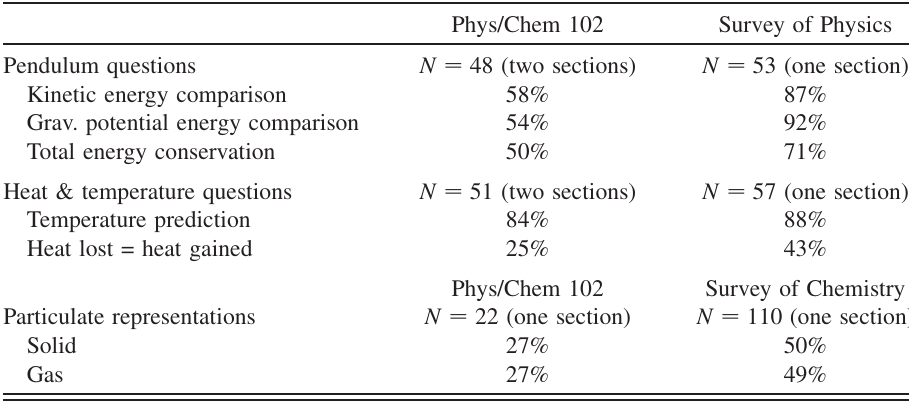
TABLE V. Comparison of fractions of students giving correct responses on a variety of common problems in Phys/Chem 102 and the corresponding survey courses in physics and chemistry at CSUF. The problems in all cases were posed at similar points in instruction, typically after reading and brief introductory lecture but before any research-based instruction.